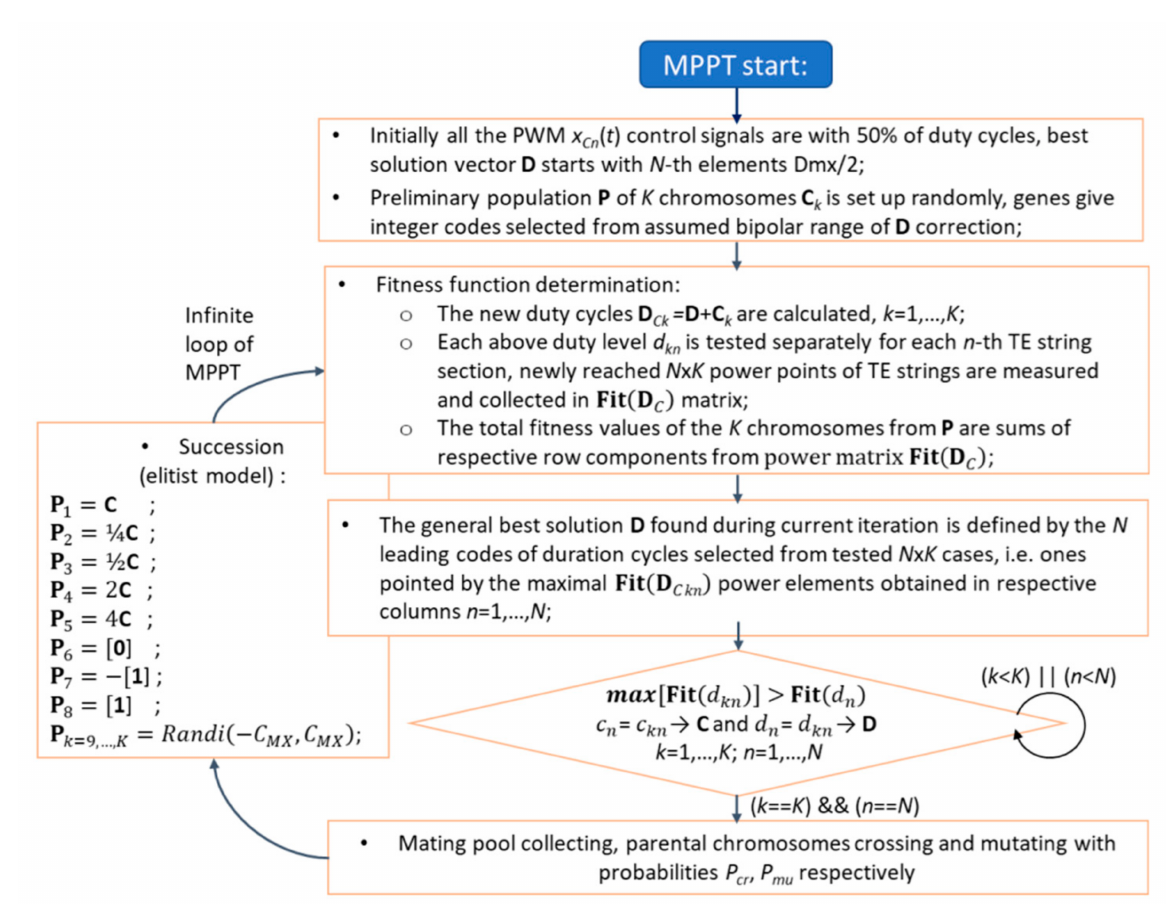
Figure 3. The proposed MPPT evolutionary method